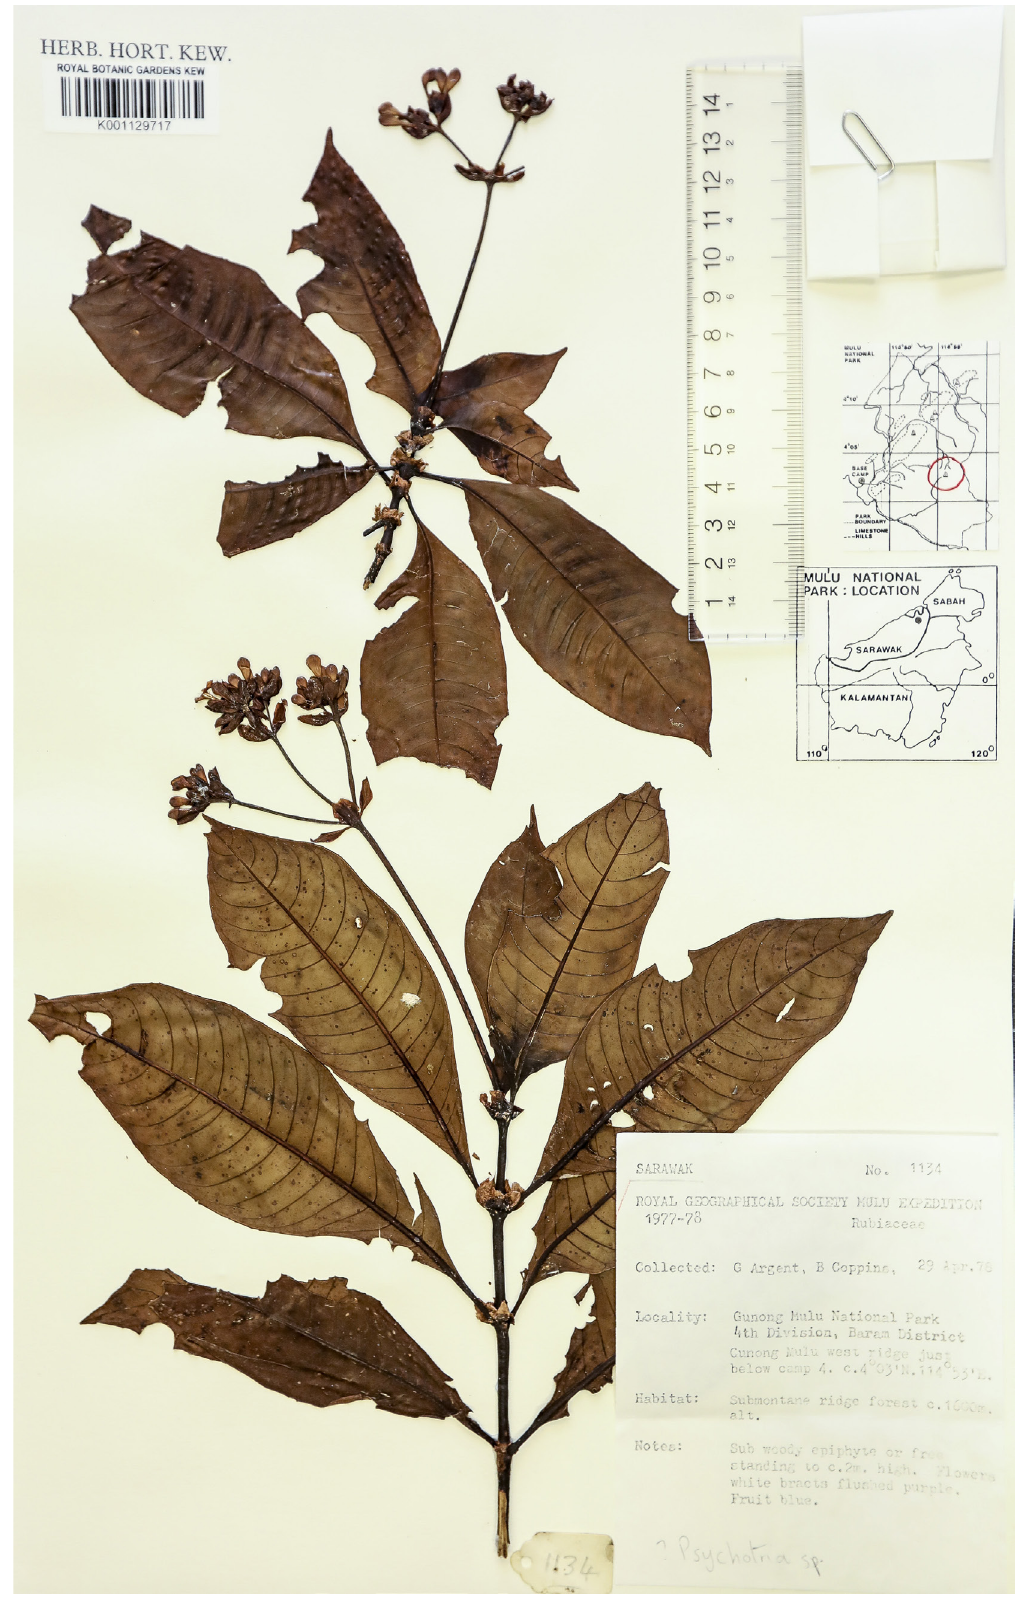
Fig. 25. Holotype of Chassalia muluensis T.Y.Yu sp. nov. ( G. Argent, B. Coppins 1134